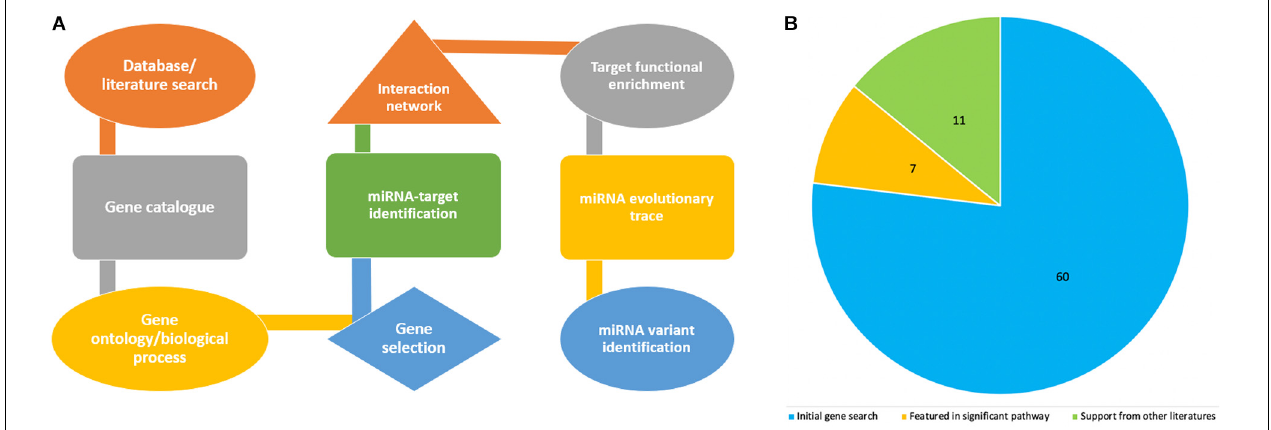
FIGURE 1 | Flowchart showing steps in the project design and analyses process (A) , while the pie chart indicates how the number of genes associated with bovine coronavirus were sorted according to significance. (B) The blue represents genes that were only from the article by Aich et al. (2007). The orange are genes from the article that also appeared in significant pathways from GO. The green are genes from the article, from significant pathways, and found in supporting literature. The green also includes the gene NANS that was added.